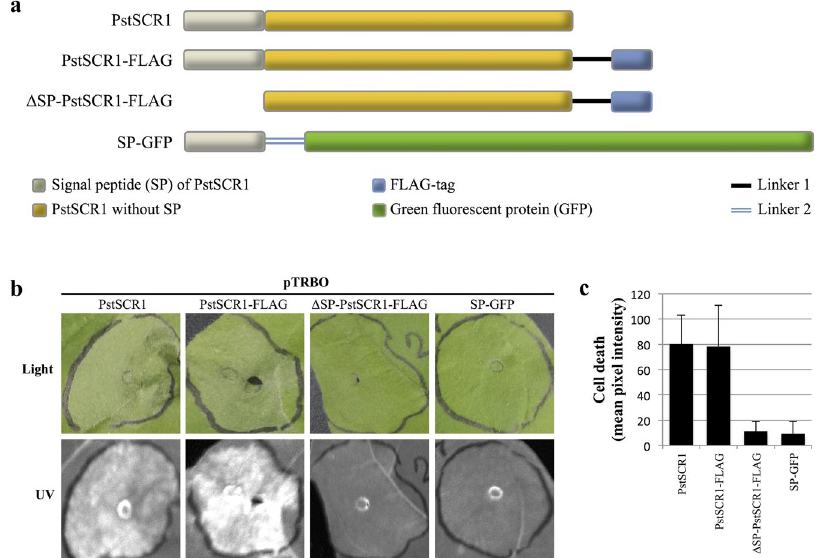
Figure 3. Secretion of PstSCR1 is required to induce cell death in N . benthamiana . ( a ) The schematic view of constructs used in the experiment. ( b ) PstSCR1 overexpressed the pTRBO vector with a secretion signal causes HR. Shown are representative N . benthamiana leaf patches expressing pTRBO/PstSCR1, pTRBO/PstSCR1- FLAG, pTRBO/ Δ SP-PstSCR1-FLAG and pTRBO/SP-GFP, 4-dpai. ( c ) Cell death quantification of infiltrated leaf regions. Pixel intensities were normalized by subtracting background in non-infiltrated zone. Error bars represent standard deviations.